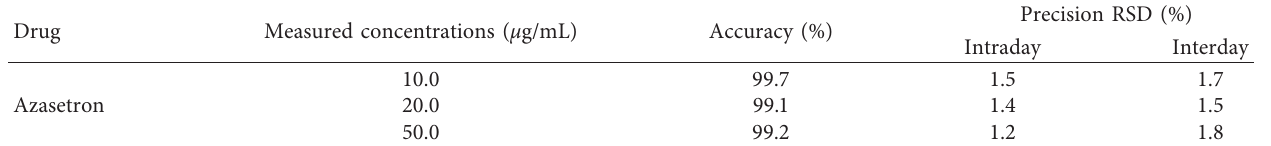
Table 2: Accuracy and precision results for the HPLC